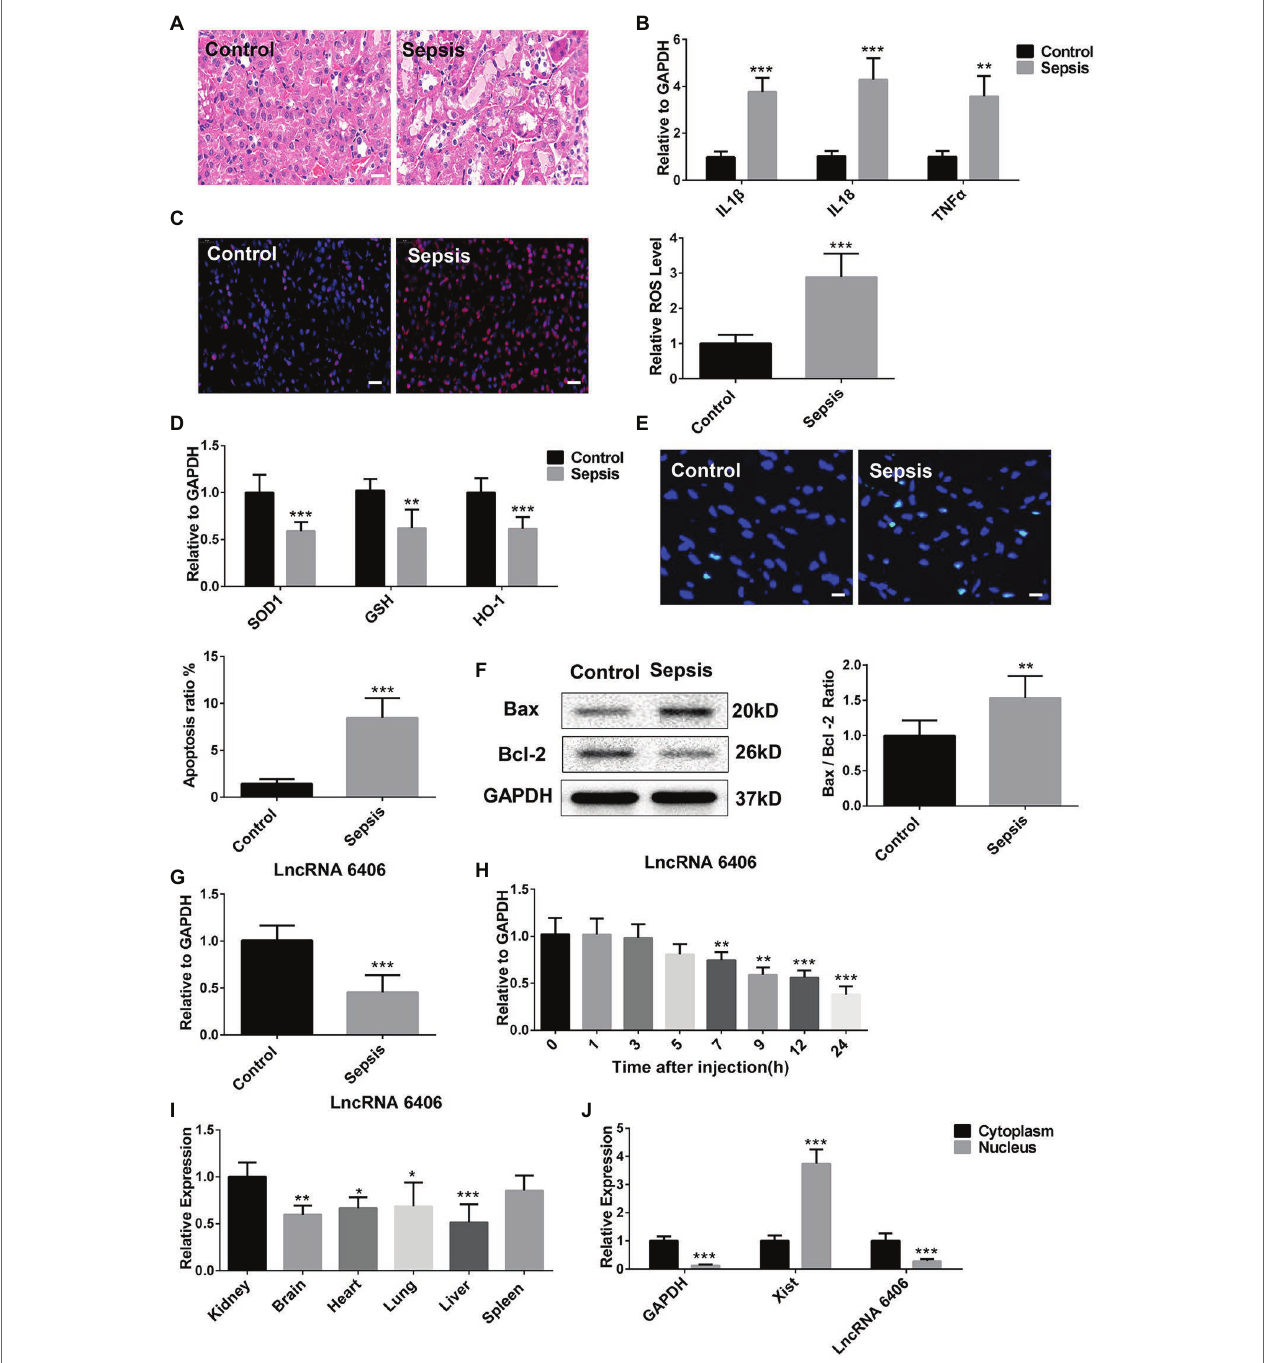
FIGURE 1 | Downregulation of long noncoding RNAs (lncRNA) 6406 was observed in the kidneys of mice in the lipopolysaccharide (LPS)-induced acute kidney injury (AKI) model. (A) HE staining was used to observe the outline of renal morphology, scale bar = 20 μ m. (B) The relative expression of inflammatory cytokines in the kidneys of mice in the LPS-induced AKI model was detected by real-time PCR (RT-PCR) analysis ( n = 6). (C,D) The LPS-induced oxidative stress in the kidneys of mice in the AKI model was determined by Dihydroethidium (DHE) staining and RT-PCR analysis ( n = 6), scale bar = 20 μ m. (E,F) The TUNEL-positive cells and Bax and Bcl-2 protein expression levels in the LPS-induced AKI model were determined to evaluate apoptosis ( n = 6), scale bar = 10 μ m. (G) The relative expression of lncRNA 6406 was detected in the AKI mouse kidneys ( n = 6). (H) The expression of lncRNA 6406 was confirmed at different time points after LPS injection in the mice ( n = 6). (I) The expression level of LncRNA 6406 was determined in different tissues ( n = 6). (J) The subcellular localization of lncRNA 6406 was detected by extracting specific subcellular fractions from the PTEC cell line ( n = 6). Each experiment was conducted independently three times. *p < 0.05; **p < 0.01; ***p < 0.001; versus respective